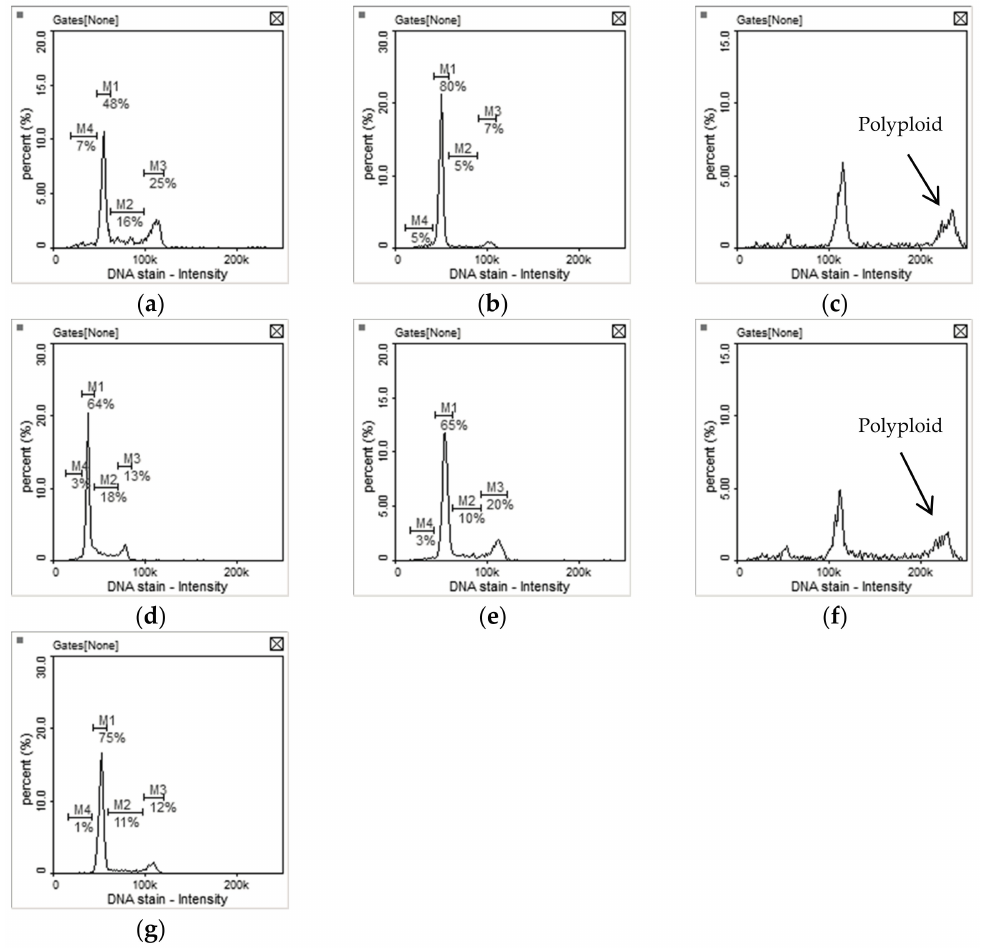
Figure 4. Cell cycle profiles of HCT-116 cells treated with ( a ) 1% DMSO (control); ( b ) 5.0 µ M of sunitinib; ( c ) 5.0 µ M of 8 ; ( d ) 5.0 µ M of 9 ; ( e ) 5.0 µ M of 10 ; ( f ) 1.0 µ M of 11 ; ( g ) 1.0 µ M of 12 for 24 h. M1: G0/G1phase, M2: S phase, M3: G2/M